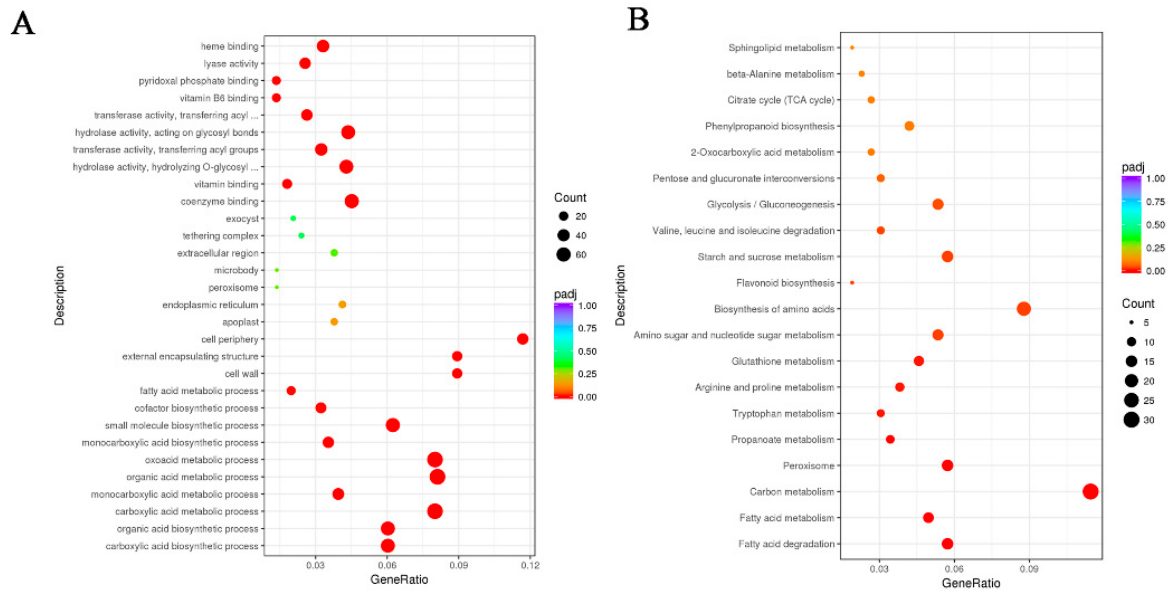
Figure 1. ( A ) GO enrichment of differentially expressed genes in Euryale ferox Salisb. ( B ) KEGG enrichment of differentially expressed genes in Euryale ferox Salisb.